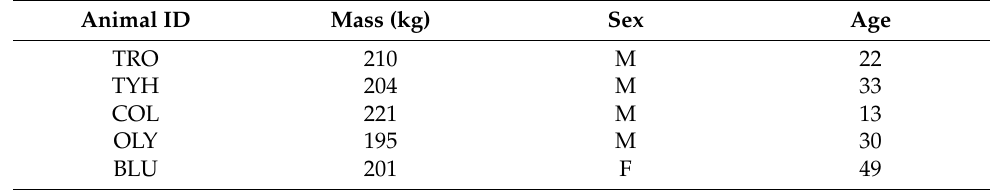
Table 1. Identification code, age, and sex for individual dolphins participating in the thyroid stimulation. Animal